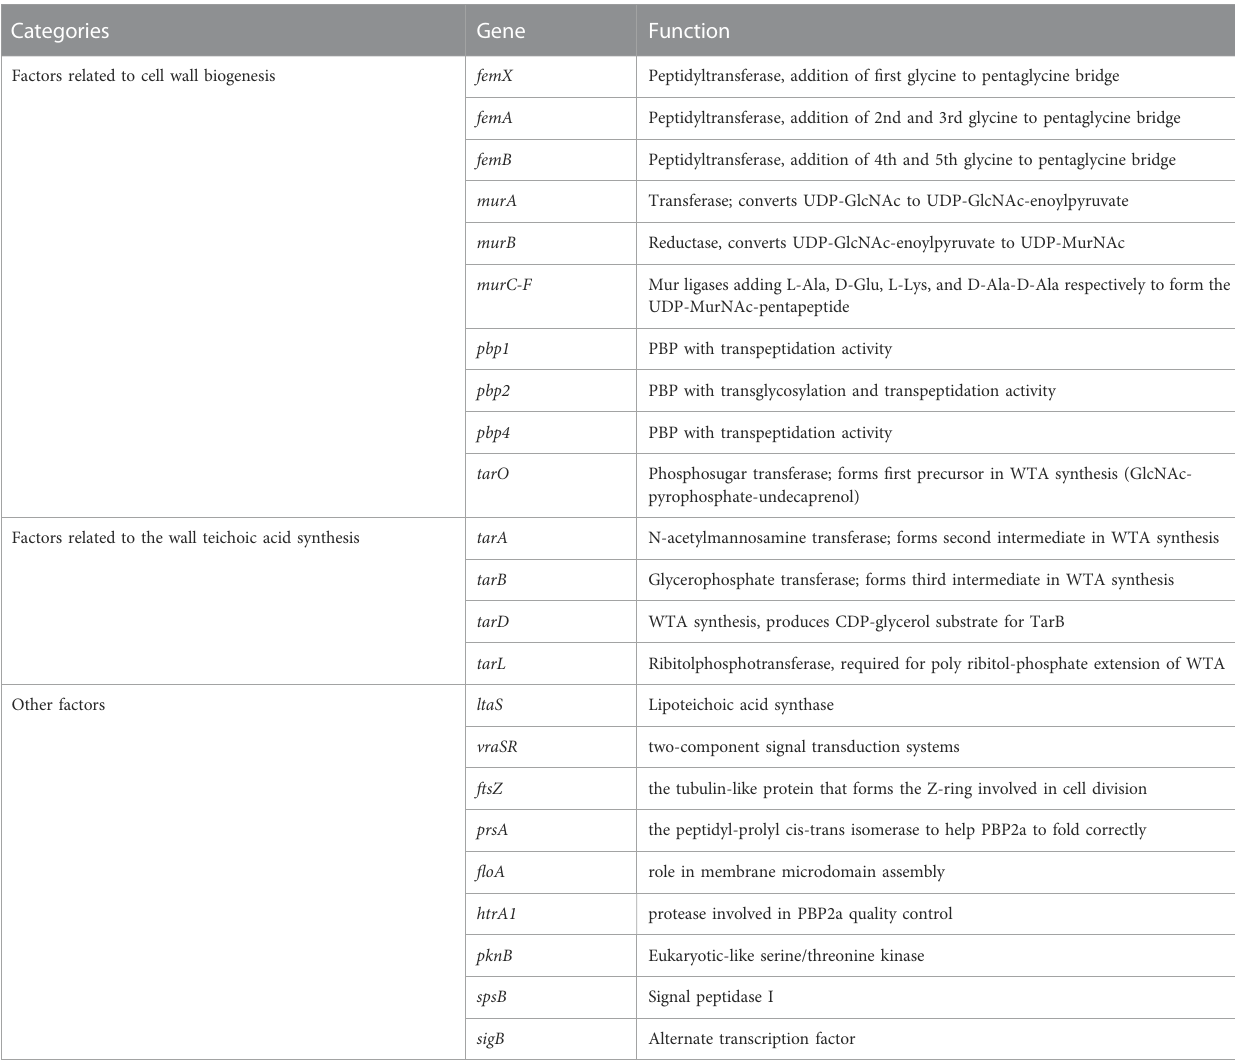
TABLE 1 PBP2a relevant factors that can induce beta-lactam